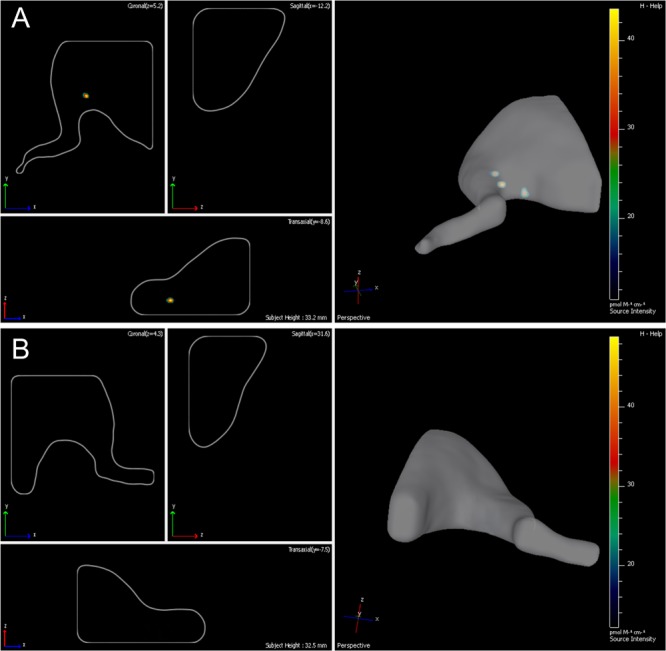
Lifetime assessment survival and migration of eGFP-ADSCs using the IVIS Spectrum system. Green fluorescence indicates the ADSCs survival and migration on the experimental side (left side) (A). There is no fluorescence on the contralateral control side (right side) (B) 14 days after the operation.